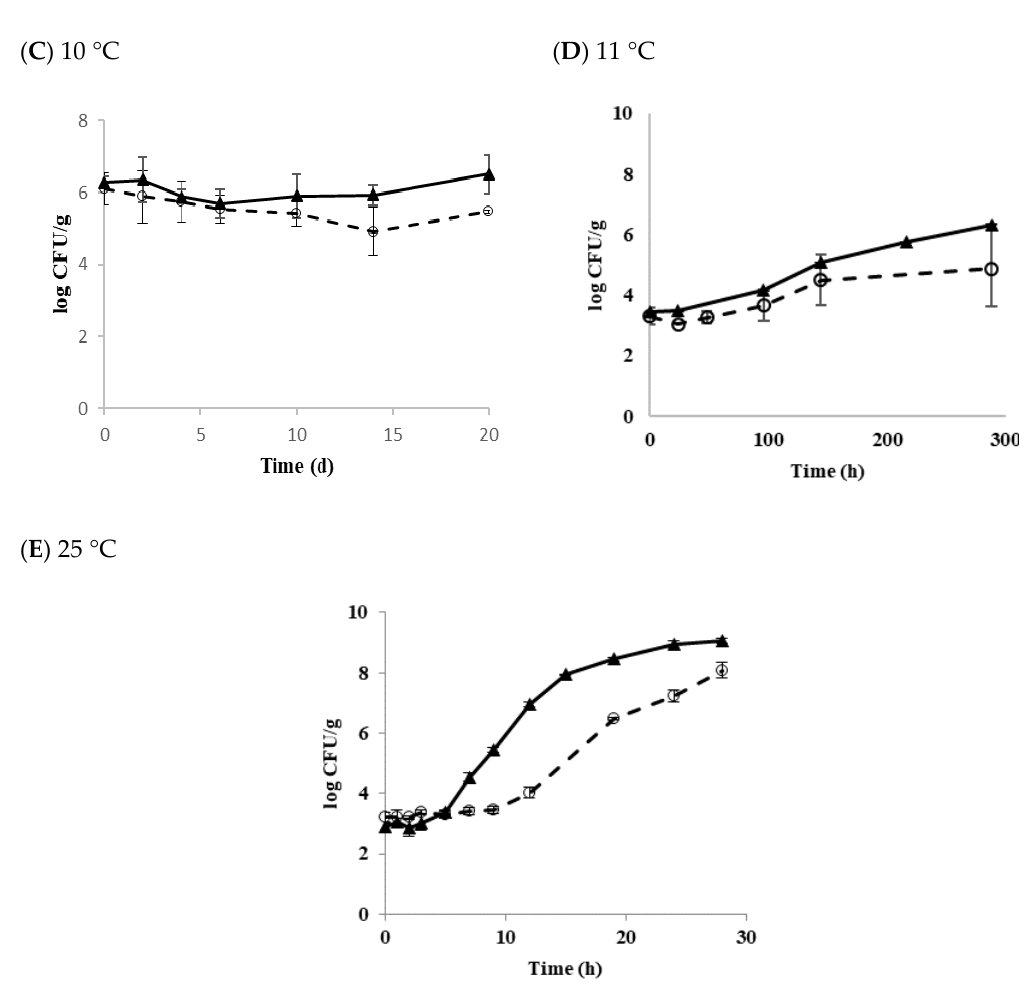
Figure 1. The growth and survival of B. cereus planktonic cells in tofu as a function of temperature. ( A ) 4 °C ; ( B ) 9 °C ; ( C ) 10 °C ; ( D ) 11 °C ; ( E ) 25 °C. Diarrheal strain; ▲ Emetic strain. (cid:35) Table 1. The growth and survival kinetic parameters of B. cereus planktonic cells in tofu.